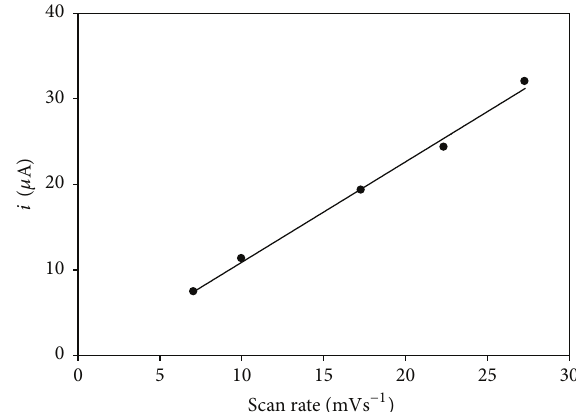
Figure 1: Cyclic voltammetry of 0.20 mM Co(TPP)Cl in 0.1M [Bu 4 N][BF 4 ]-95% MeCN+ 5% DMF, scan rate 100 mVs −1 at vitreous carbon electrode under Ar.